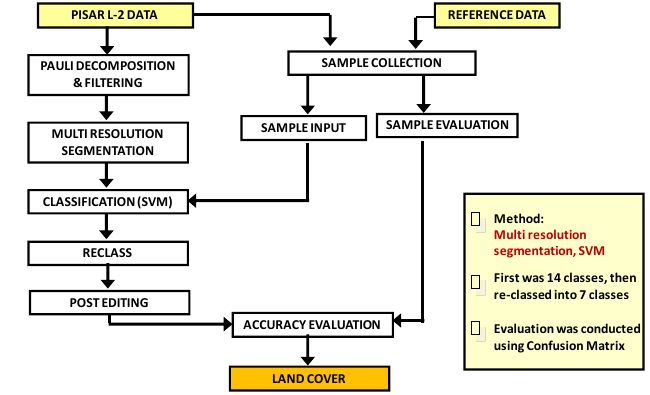
Figure 2. Flowchart of the pixel-based classification using